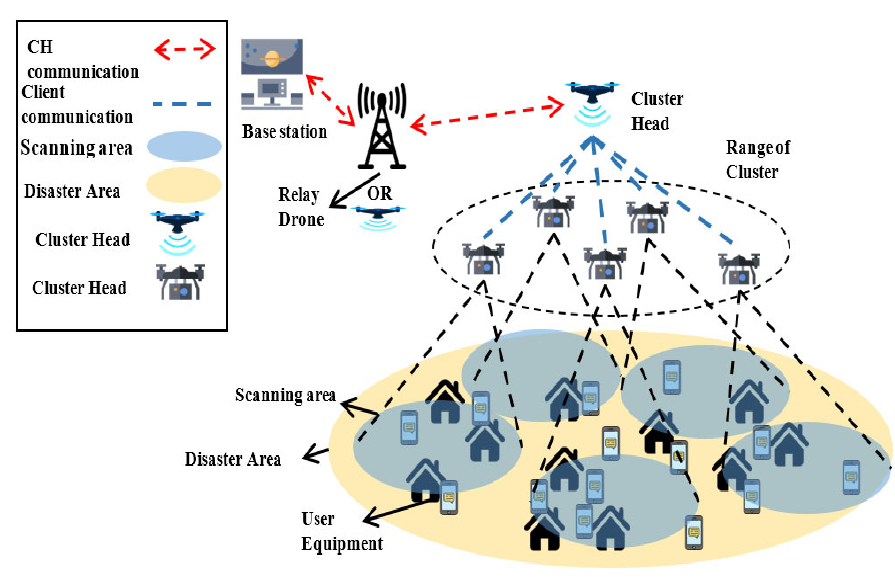
Figure 2. Multi ‐ hovering UAVs’ communication. Figure 2. Multi-hovering UAVs’